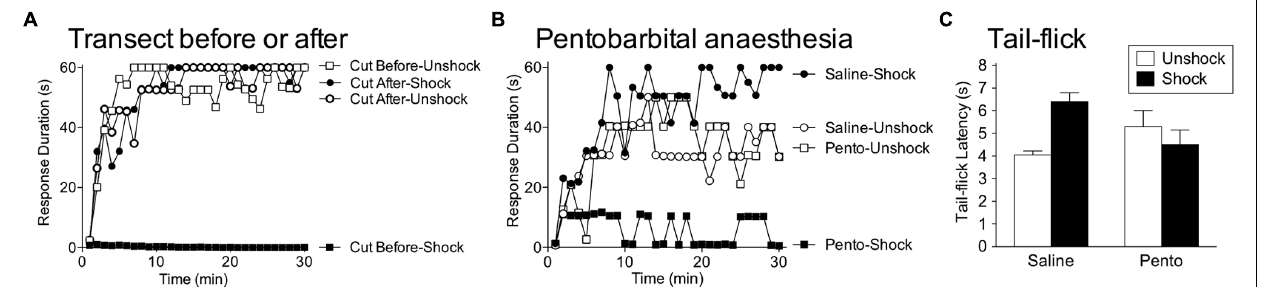
FIGURE 9 | Brain systems transform how shock affects spinal function. (A) Rats receivedVIS (Shock) or nothing (Unshock) before or after a spinal transection (Cut) and were tested for instrumental learning the next day. When the spinal cord was cut prior to treatment, shock induced a learning impairment (Cut Before-Shock).When the spinal cord was cut after shock treatment (Cut After-Shock), no impairment was observed. (B) Intact rats were anesthetized with pentobarbital (50 mg/kg, i.p.) or given saline. Subjects then receivedVIS (Shock) or nothing (Unshock), followed by a spinal